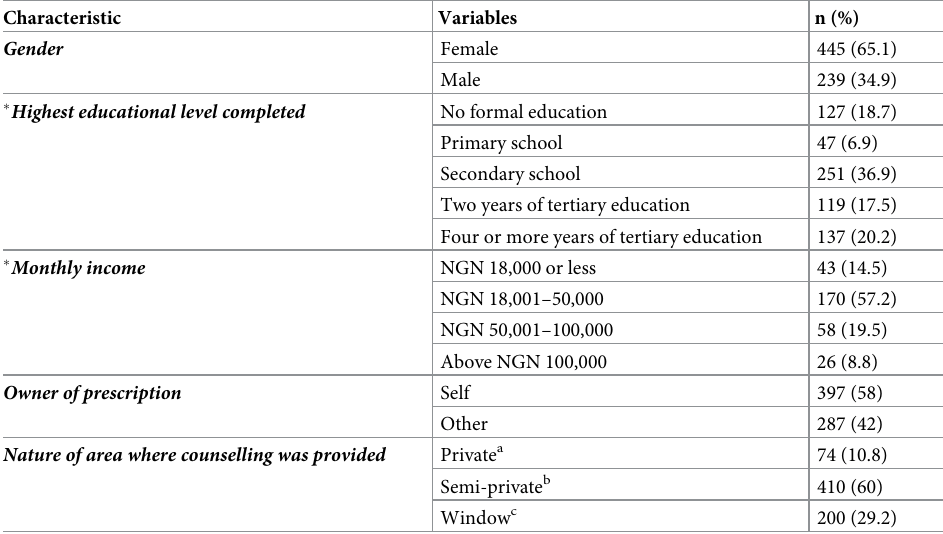
Table 1. Demographic and other characteristics of exit interview respondents (n = 684).